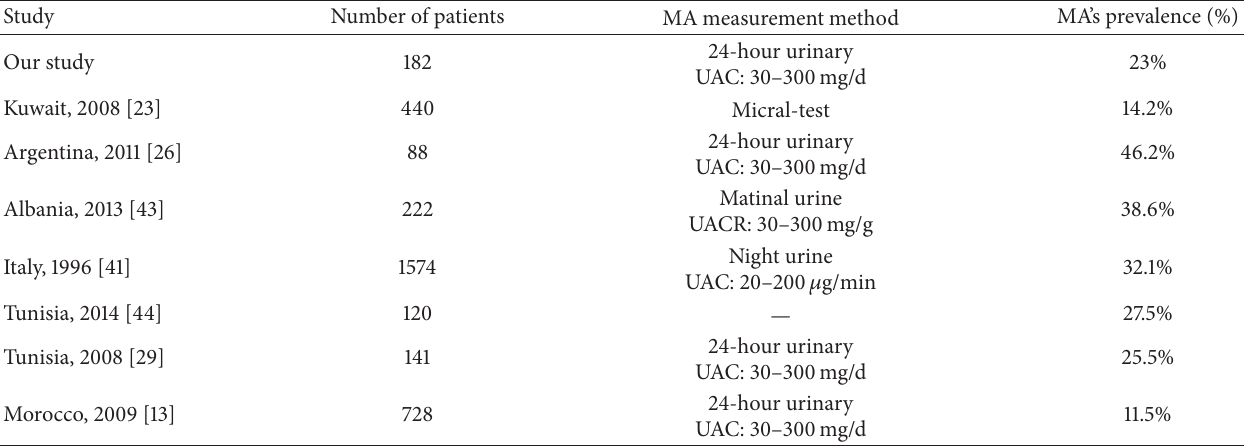
Table 3: Microalbuminuria’s prevalence in the literature.